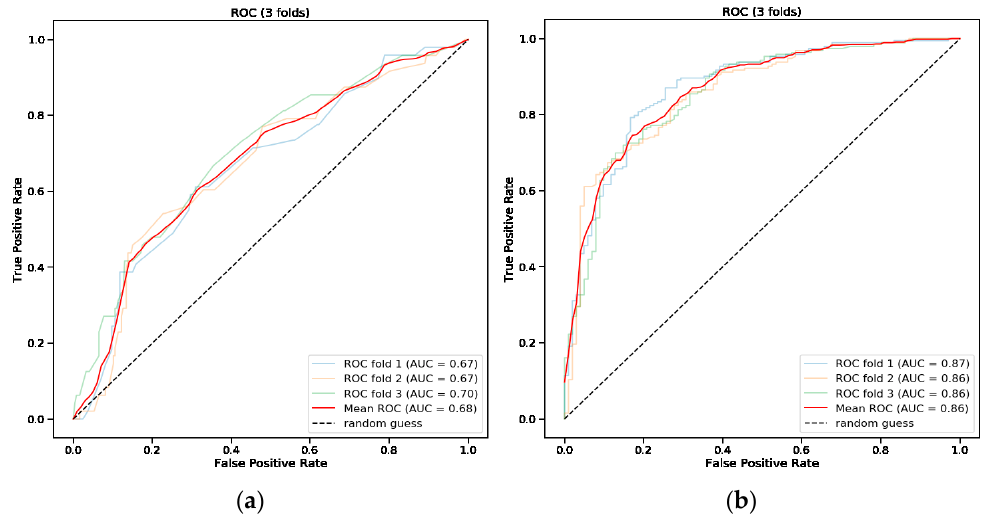
Figure 2. Receiver operating characteristic (ROC) curves * of the new modified model for endoscopic intervention ( a ) and packed blood cells transfusion ( b ). * Cross-validation curves and their mean. AUC, area under the curve.